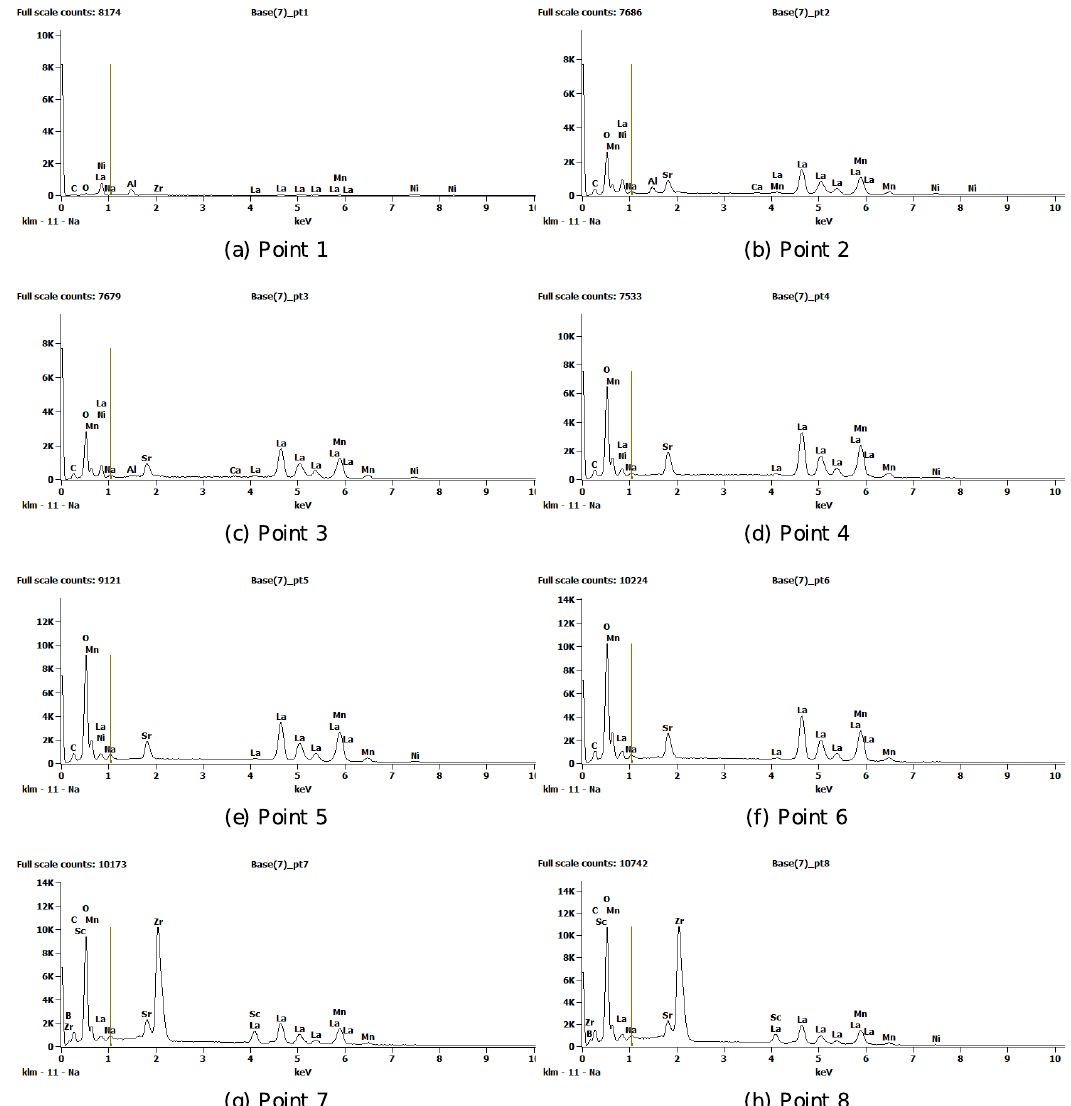
Figure 7. X-ray Diffraction (XRD) patterns of LSM current collecting layer in the cathode and the ScSZ/LSM cathode electro-catalytic